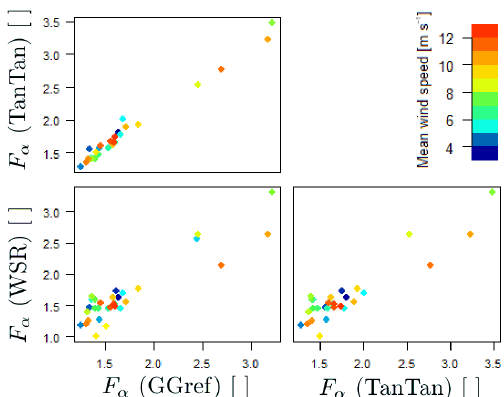
Figure 9. F α calculated with three methods over a large database of wind turbines. Colour-coded according to the mean wind